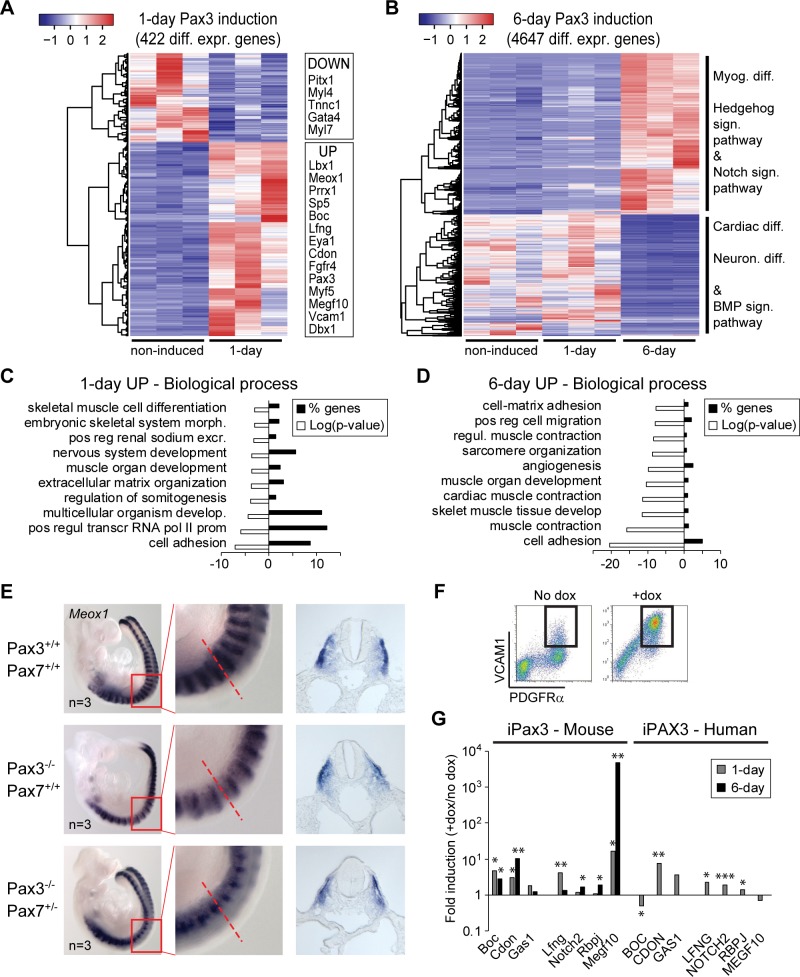
Conserved role of Pax3 in the regulation (“regul.”) of somitic/myogenic gene expression.(A-B) Heatmap of genes up-regulated upon 1-day and 6-day Pax3 induction. Changes are relative to noninduced Pax3 cells and were obtained by the analysis of 3 independent biological replicates. Selected genes and biological processes affected by Pax3 are indicated on the right side of the heatmaps. (C-D) GO analysis of up-regulated Pax3 genes: 1-day and 6-day samples using DAVID. (E) Analysis of Meox1 expression in the somites of WT and Pax3-null;Pax7-het E9.5 embryos using ISH. Red square represents the zoomed region (middle panel). Dashed red line indicates the section displayed in the right panel. (F) Representative FACS analysis of 2-day Pax3-induced EB cultures shows up-regulation of VCAM1 (y-axis). PDGFRα expression is shown on the x-axis. (G) Comparison of transcriptional changes for selected genes associated with Hedgehog and Notch signaling (“sign.”) pathways upon Pax3 expression in differentiating mouse and human ES cells. Data were extracted from RNA-seq analysis of 1-day and 6-day Pax3-induced (+dox) and noninduced (no dox) cultures. Bars represent fold induction (+dox/no dox) of each sample’s mean. *p < 0.05, **p < 0.01, ***p < 0.001. Numerical values are available in S1 Data. BMP, bone morphogenetic protein; develop., development; diff., differentiation; diff. expr., differentially expressed; dox, doxycycline; E, embryonic day; EB, embryoid body; excr., excretion; FACS, fluorescence-activated cell sorting; GO, gene ontology; ISH, in situ hybridization; Meox1, mesenchyme homeobox 1; morph., morphogenesis; Neuron., neuronal; Pax, paired box; PDGFRα, platelet-derived growth factor receptor alpha; pos reg, positive regulation; pos regul transcr RNA pol II prom, positive regulation of transcription from RNA pol II promoter; VCAM1, vascular cell adhesion molecule 1; WT, wild-type.